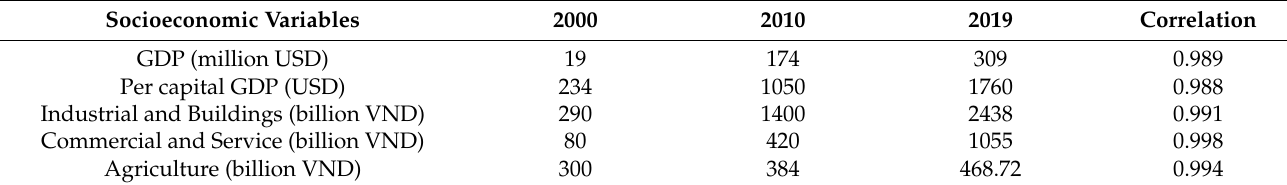
Table 9. Changes of socioeconomic factors from 2000 to 2019 and correlations with the built-up area. Socioeconomic Variables